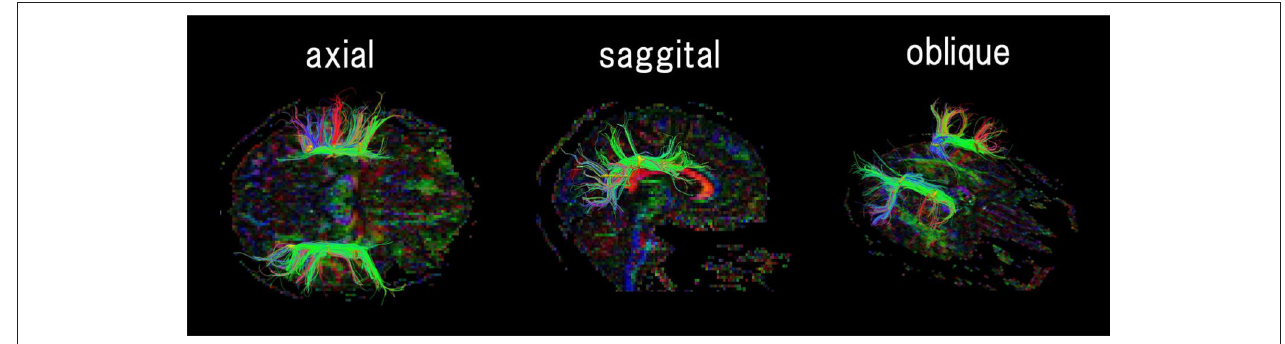
FIGURE 1 | An example of regions of interest (ROIs, shown in yellow) placement for identifying the arcuate fasciculus. According to the human brain fiber atlas (Catani and Thiebaut de Schotten, 2008), ROIs were carefully placed along expected AF fiber pathways on a FA color map. The color coding of fibers is based on a standard RGB code, applied to the vector between the end-points of each fiber (Red: left-right, Green: anterior-posterior, and Blue: